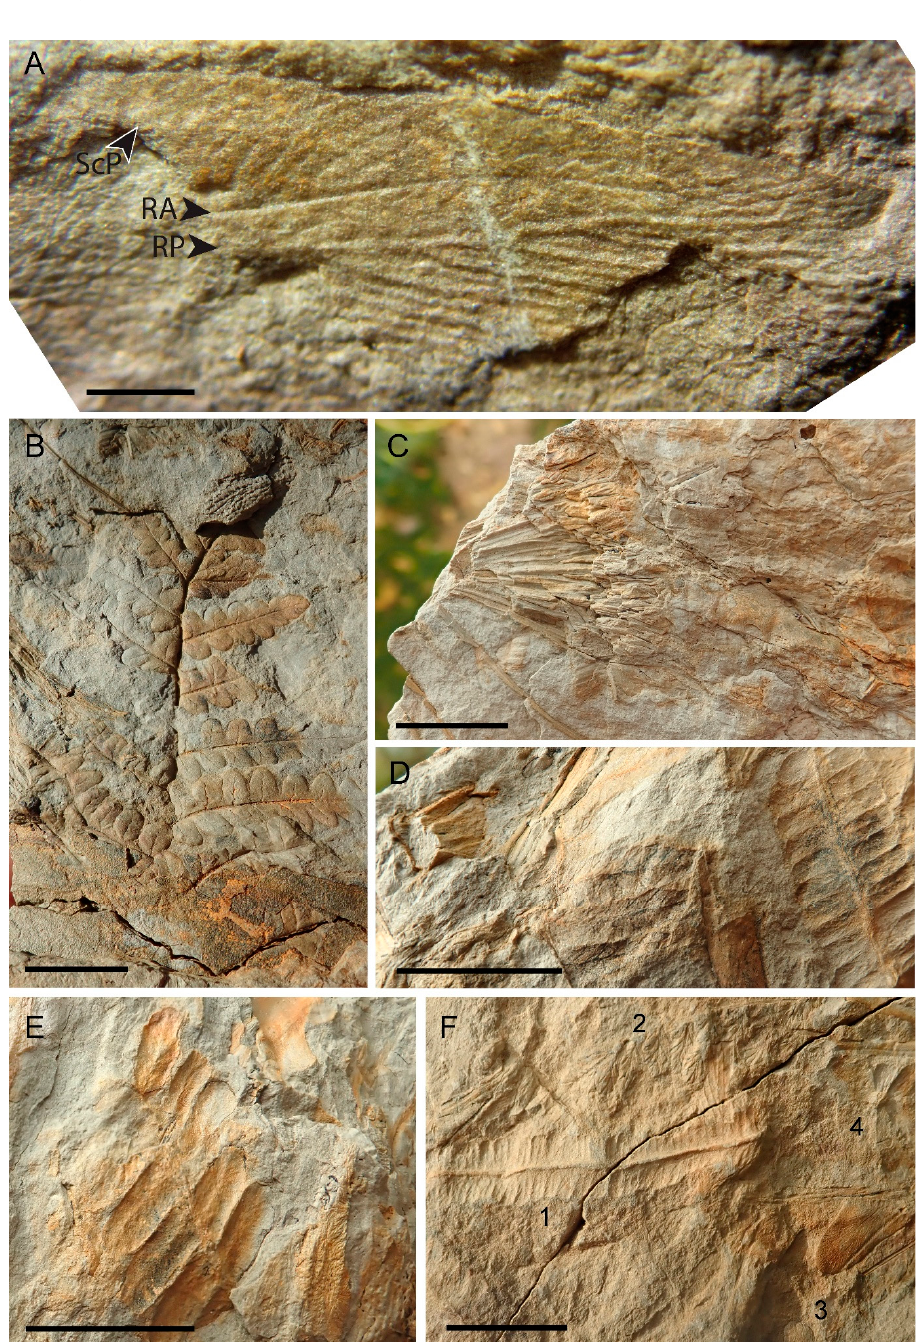
Figure 4. Assemblage of wing fragment and plant remains in the same slab (MGM-822H), Gzhelian of El Bierzo, Spain. Photographs: ( A ) wing fragment of Glaphyrophlebia sp., specimen MGM-822H-1; ( B ) Oligocarpia gutbieri , MGM-822H-2; ( C ) Dicranophyllum gallicum , MGM-822H-3; ( D ) Oligo- carpia leptophylla (left), MGM-822H-4, and Diplazites unitus (right), MGM-822H-5; ( E ) Pecopteris daubreei , MGM-822H-6; ( F ) Diplazites unitus : (1) Sphenopteris sp. aff. mathetii , (2), cf. Odontopteris sp., (3) Sphenophyllum oblongifolium , and (4) specimens MGM-822H-7 to MGM-822H-10, respectively. All stacked images. Abbreviations: RA = radius anterior, RP = radius posterior, ScP = subcostal posterior. Scale bars = 1 mm ( A ), 1 cm ( B – F